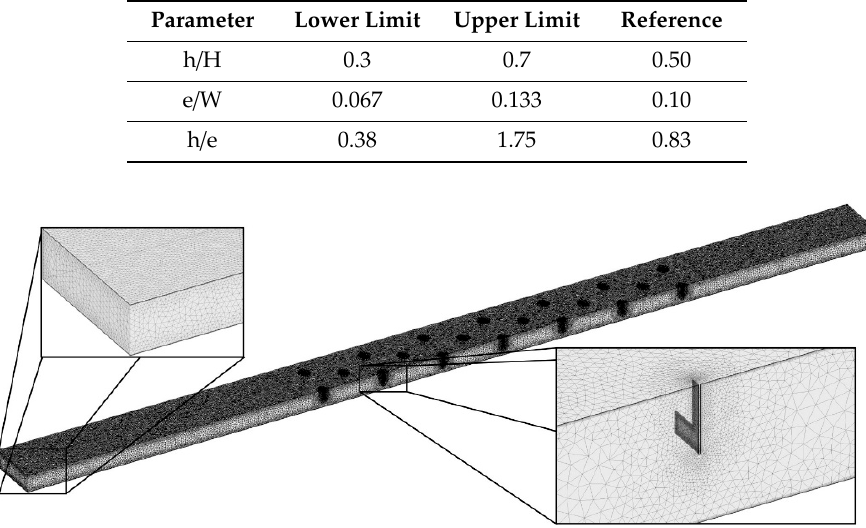
Figure 2. Example of grid system.